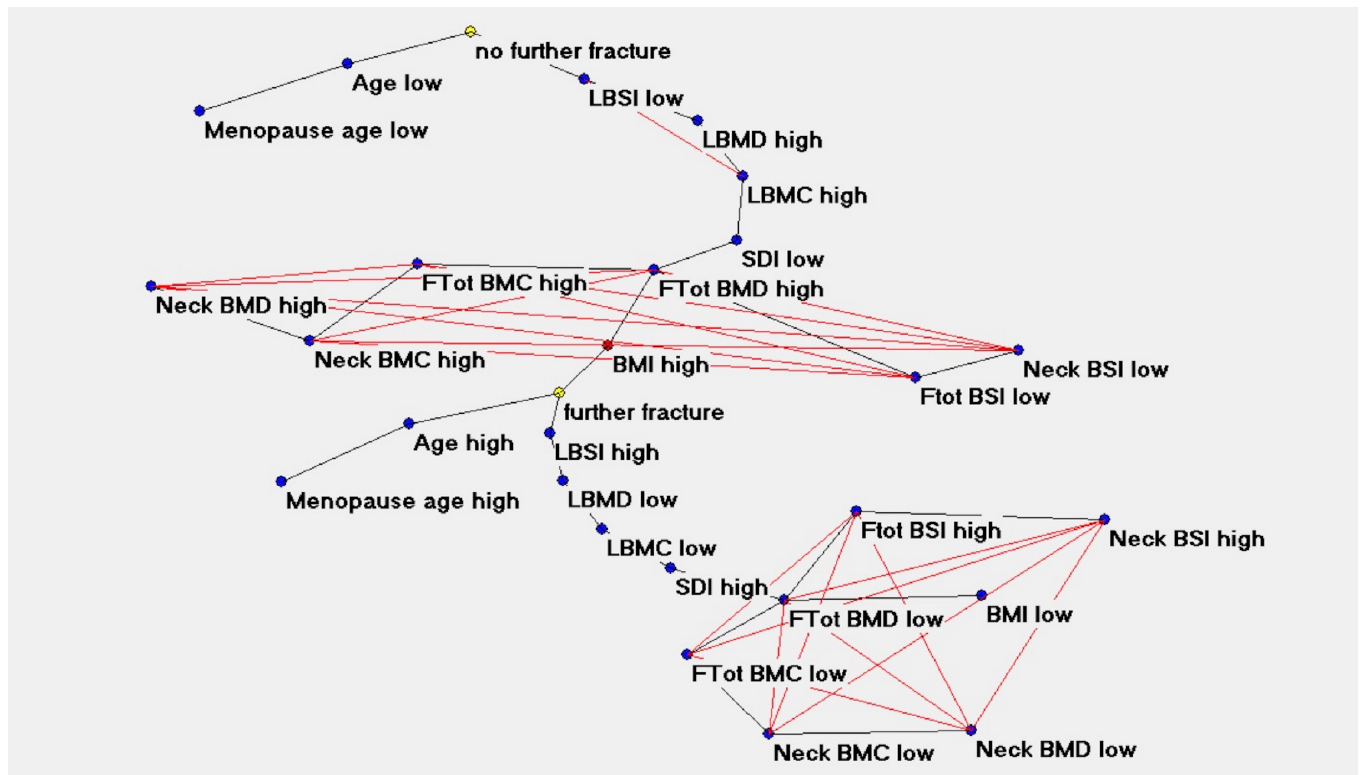
Fig 4. Semantic connectivity map with maximally regular